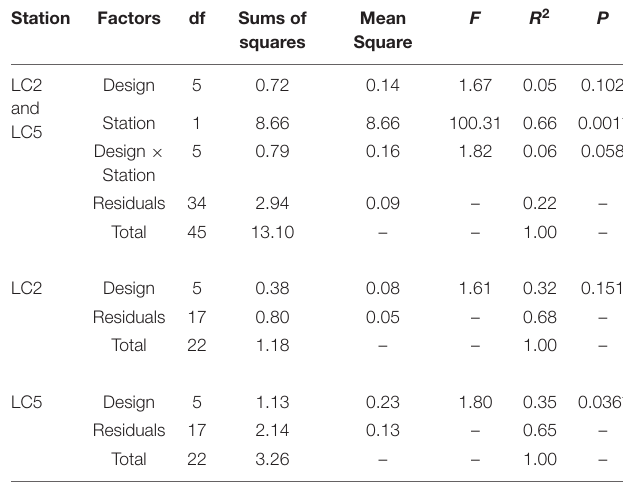
*Denotes significant p-value using α = 0.05. Using 23 taxon in total, some that were found only at one station. Based on mean abundance data by transect.